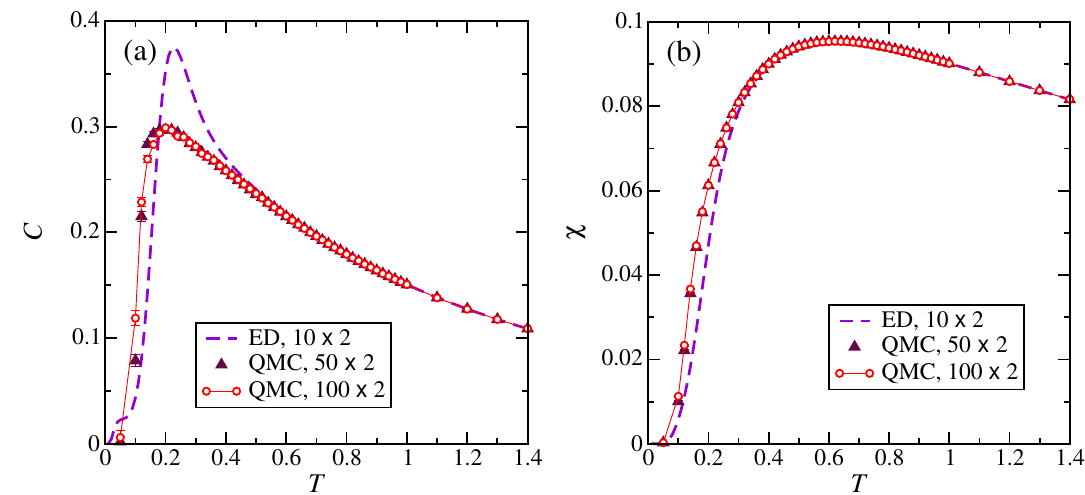
Figure 8: Magnetic specific heat, C , and susceptibility, χ , shown per spin for a ladder with rung coupling J ⊥ = 1.32, leg coupling J (cid:107) = 1, and diagonal coupling J × = 0.9. We compare QMC results obtained for ladders of L = 50 and 100 rungs with ED results for L = 10. The line connecting the L = 100 QMC data points is a guide to the eye.